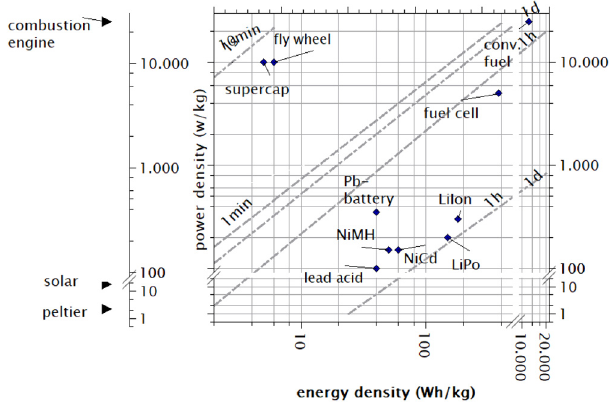
about the operation time of a mobile device with an energy - storage system under maximum